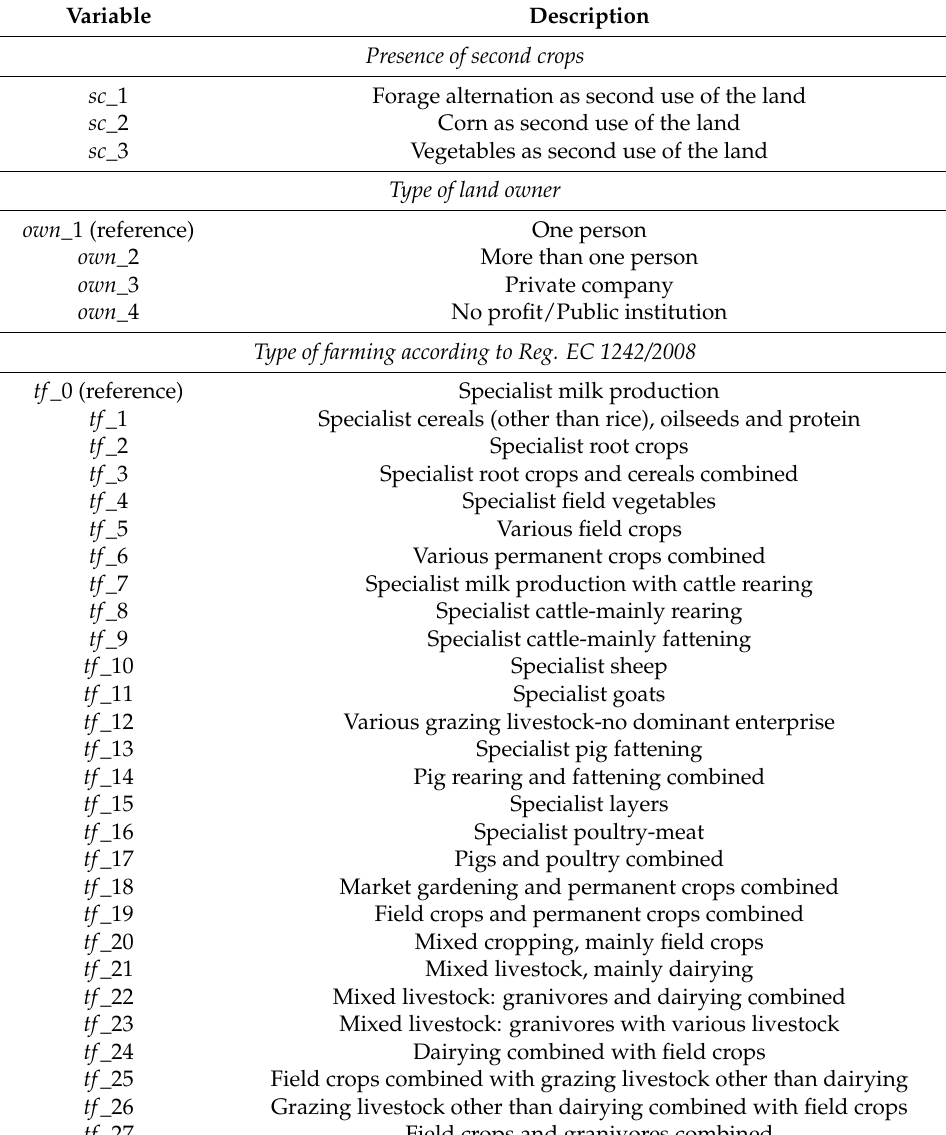
Table B1. Legend of some control variables in Table